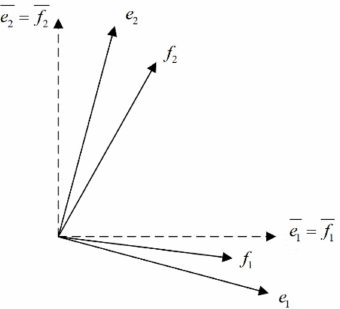
Figure 3. Rigid body rotation and fiber